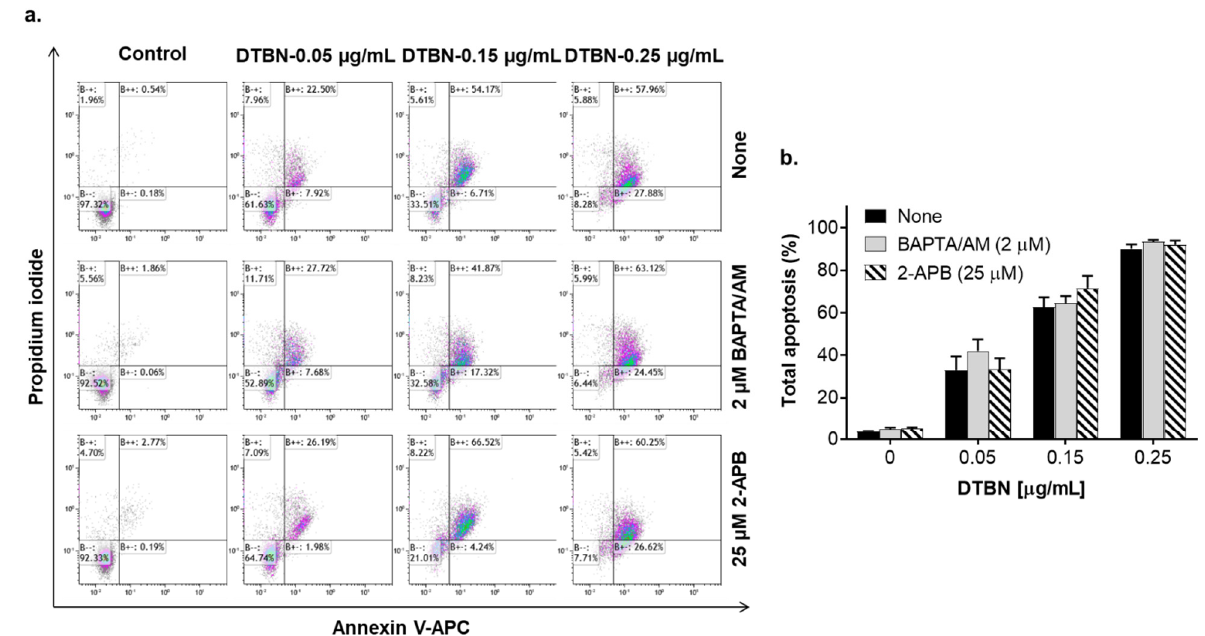
Figure 11. 6,6 ′ -dihydroxythiobinupharidine (DTBN)-induced apoptosis is not mediated by Ca 2+cyt . HL60 cells were preincubated with BAPTA/AM (1 µM) or 2-APB (25 µM) for 1 h, followed by treatment with the indicated concentrations of DTBN for 24 h. The extent of apoptosis was measured by the annexin-V/PI assay. ( a ) Typical flow cytometric data from a representative experiment; ( b ) Averaged percentages of apoptotic (early + late) cells. The data are means ± SD of 3 independent experiments performed in duplicate.